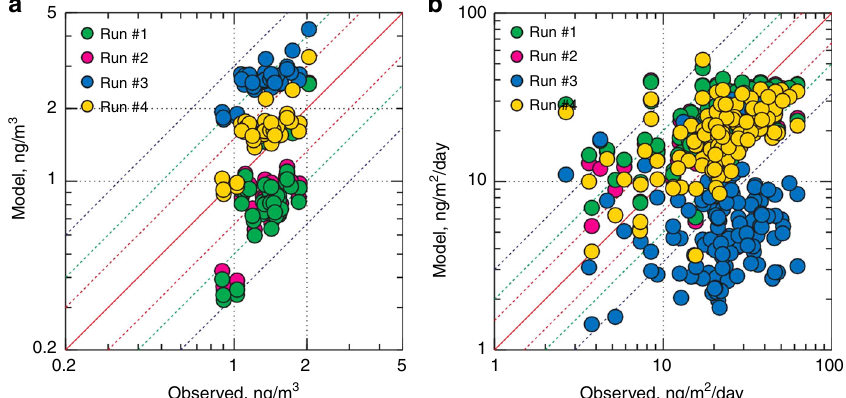
Fig. 7 Comparison between simulations from the GLEMOS model with measurements for the year 2013: a Hg(0) air concentration; b Hg(II) wet deposition. The measurement dataset is the same as in ref.